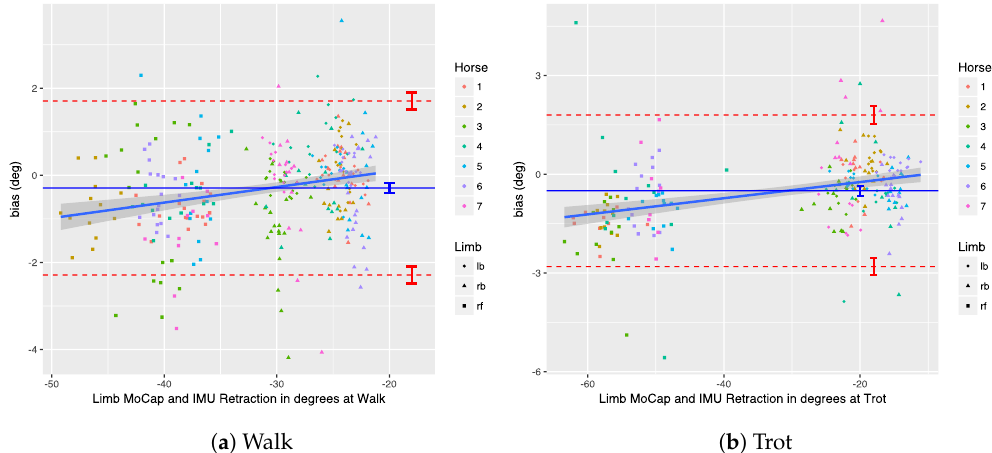
Figure 20. Bland–Altman analysis for retraction angles at walk and trot.